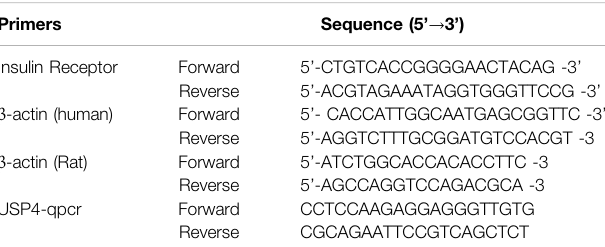
TABLE 1 | Primers used in Quantitative Real-Time PCR.